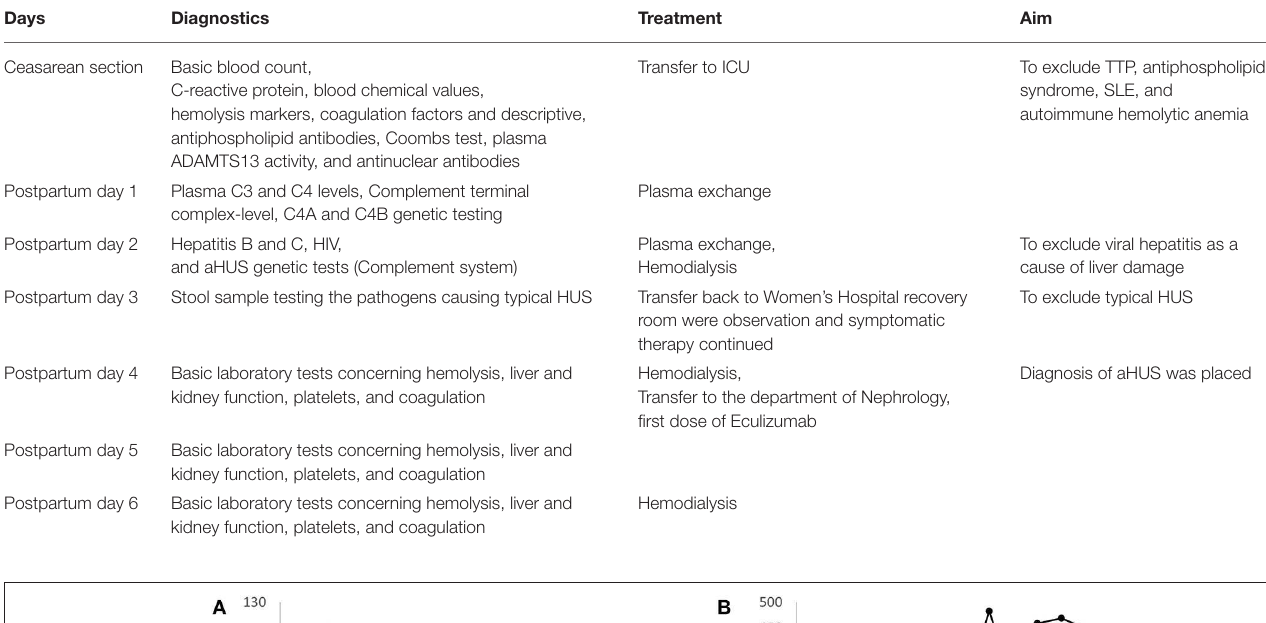
TABLE 2 | Timeline of the disease diagnostics and treatment. Days Diagnostics Treatment